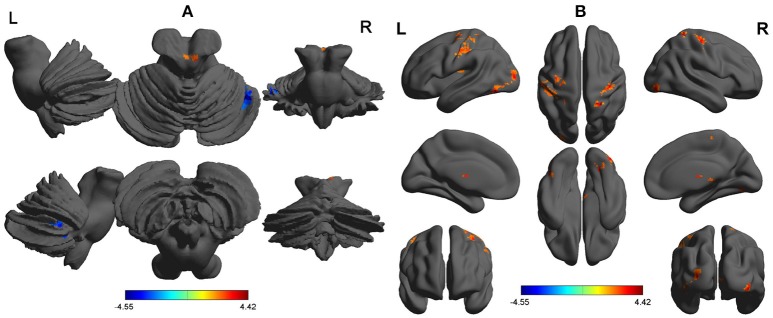
ALFF differences between SD group and RW group. The differences covered cerebellum with lower ALFF (A), and inferior occipital gyrus, thalamus, insula, and postcentral gyrus with higher ALFF (B). The color in the map represents the differences. The red color signifies increase in ALFF areas, and the blue signifies decrease in ALFF areas. ALFF, Amplitude of low-frequency fluctuations; SD, Sleep deprivation; RW, Rested wakefulness; R, right; L, left.